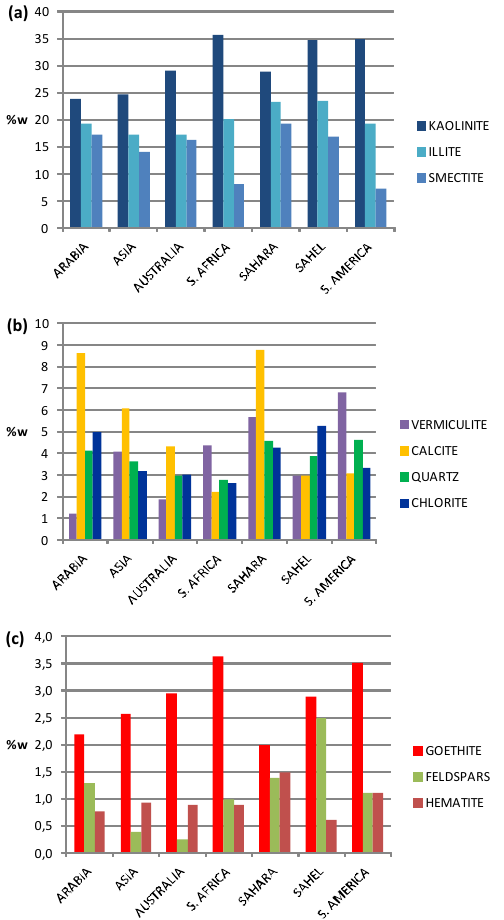
Fig. 10. Global yearly average composition (in mass percentage) of (a) clay fraction of soil and (b) airborne